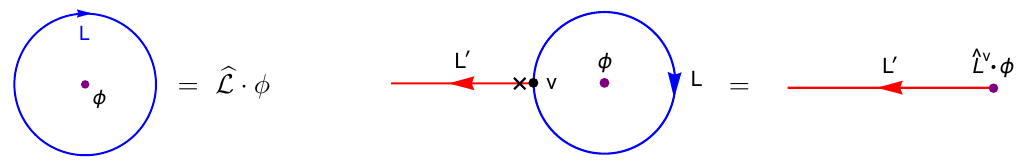
Figure 14 . Left: Contracting a TDL L loop on a bulk local operator (cid:30) produces another bulk local operator ( b L (cid:1) (cid:30) ) of the same weight. Right: \Lassoing" the bulk local operator (cid:30) with an L loop attached to the L 0 line produces a defect operator in H L 0 .